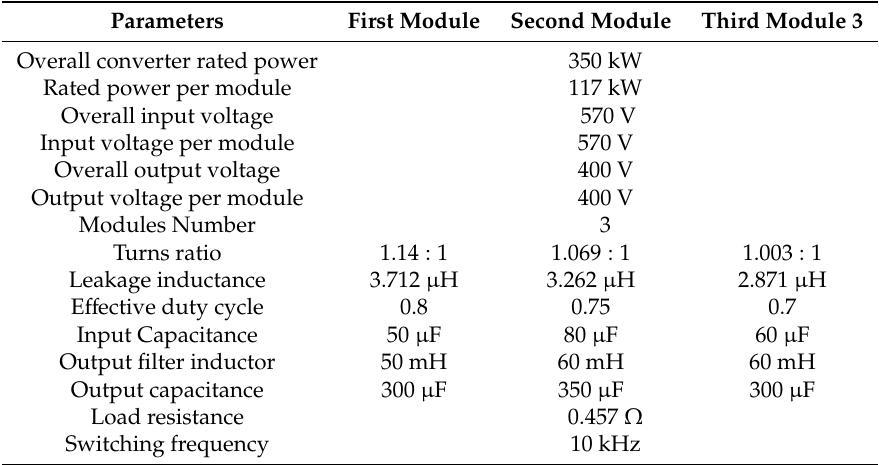
Table 9. Input-Parallel Output-Parallel (IPOP) converter parameters.